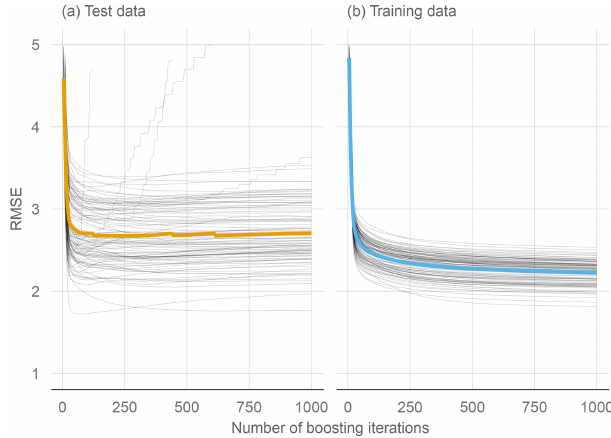
Figure 3. Prediction error for the unseen test data (a) and the train- ing data (b) . Bootstrapping was performed 100 times where the training set consists of 70% of the